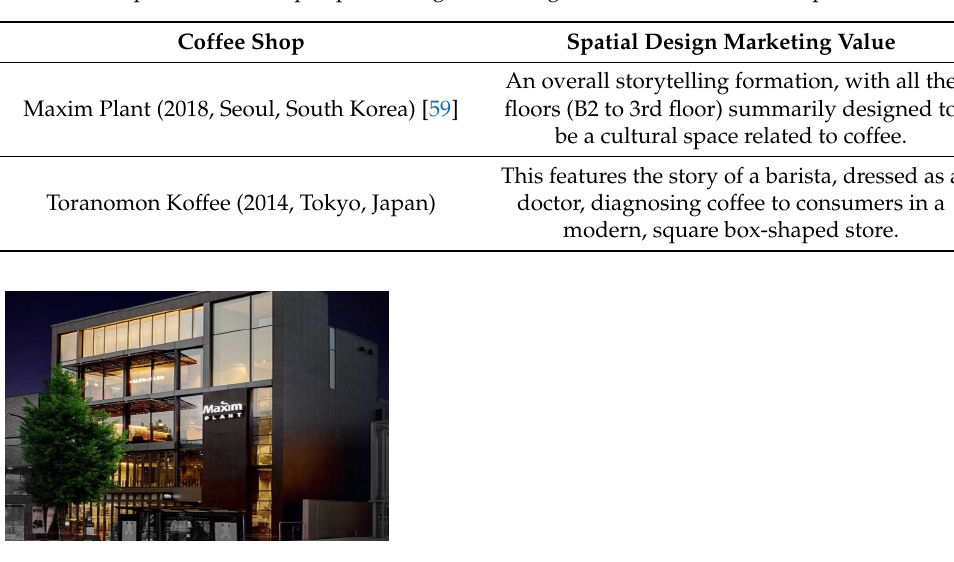
. . Figure 10. Café Slow (2001, Tokyo, Japan). Figure 10. Café Slow (2001, Tokyo, Japan).